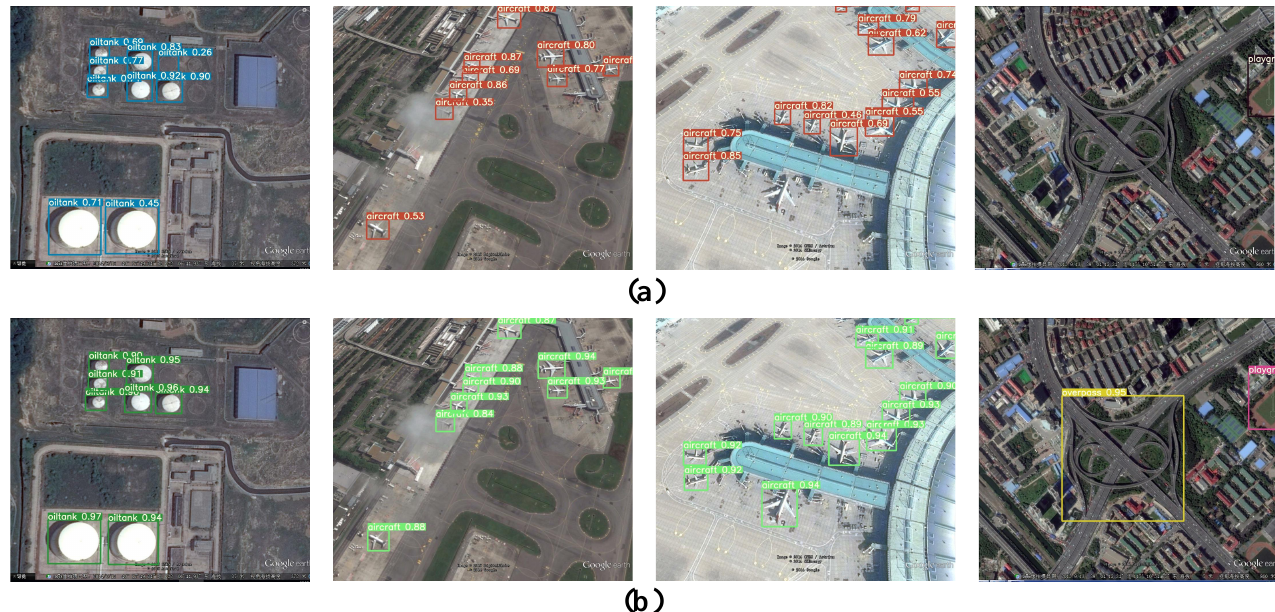
Figure 9. This is the comparison results using the improved object detection module and the original YOLOv5. ( a ) is the result of the conventional YOLOv5, ( b ) is the result of the improved object detection